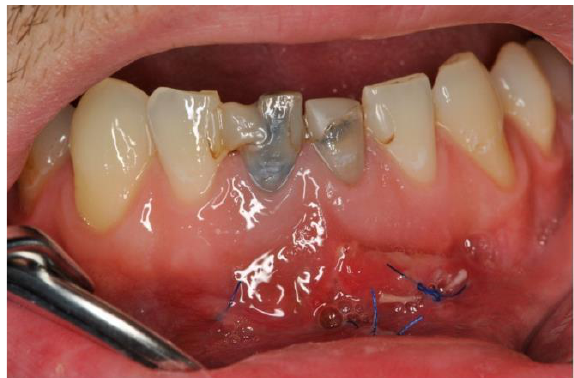
Figure 6. Bland wound conditions on the operation site before suture removal 13 days postoperatively. A second postoperative checkup 6 weeks later revealed a self-dissolving suture pro- truding through the mucosa. This was shortened and the wound closed without compli- applied in a layering technique to improve esthetics in the vestibular region of 31 and 41. Histopathologic examination confirmed the tentative diagnosis of a radicular cyst. A CBCT, shown in Figure 7, was performed 11 months after surgery.